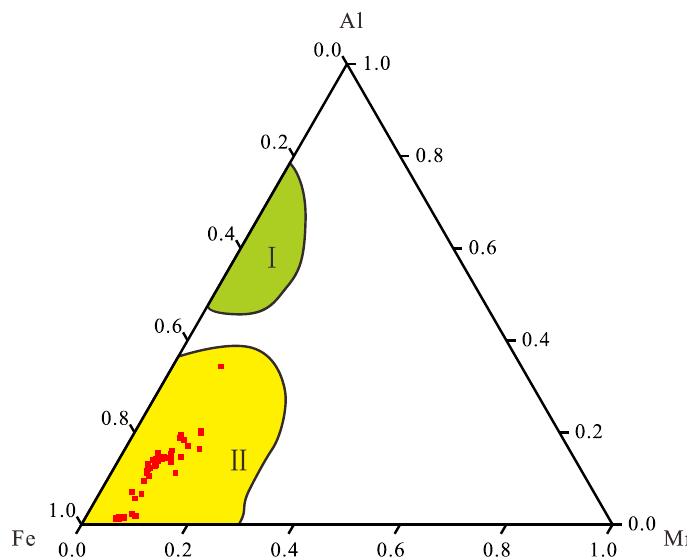
Figure 6. Through the Al-Fe-Mn ternary plot analysis, siliceous minerals from the Upper Ordovician Xinkailing Formation – Lower Silurian no. 1 section of the Lishuwo Formation in the Jiangye-1 well contain excess siliceous minerals, which are derived from hydrothermal origin. The base map is from Wedepohl [26], Adachi et al. [27] and Yamamoto [46]. See Figure 1 for the well location. I: bio-origin, II: hydrothermal origin.